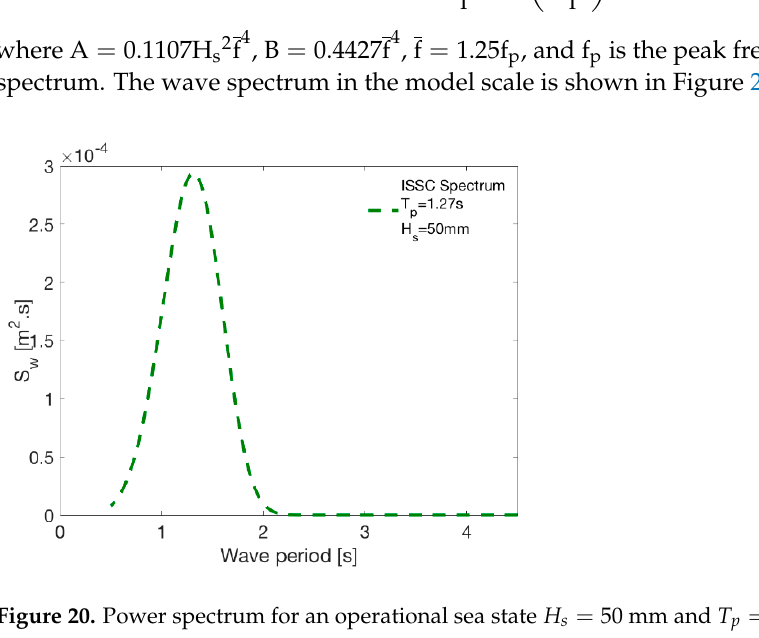
Figure 20. Power spectrum for an operational sea state H s = 50 mm and T p = 1.27 s in model scale.